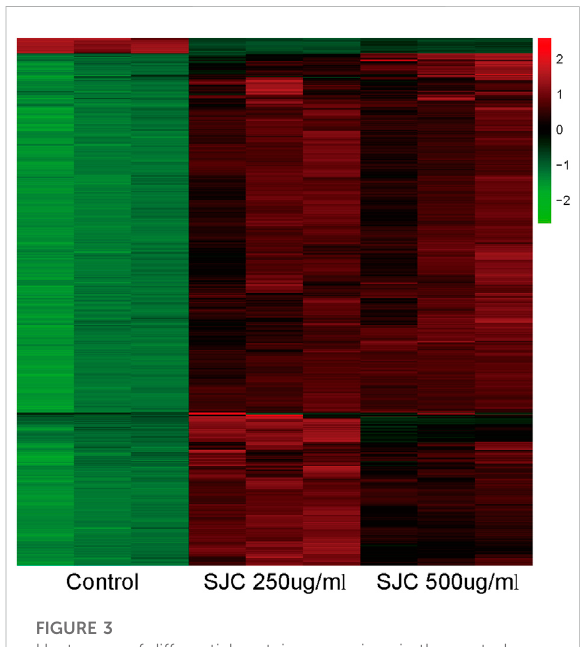
FIGURE 3 Heat maps of differential protein expressions in the control group, SJC250 μ g/ml, and SJC500 μ g/mlmedicationgroup. Up- and down-regulated genes are indicated in red and green,